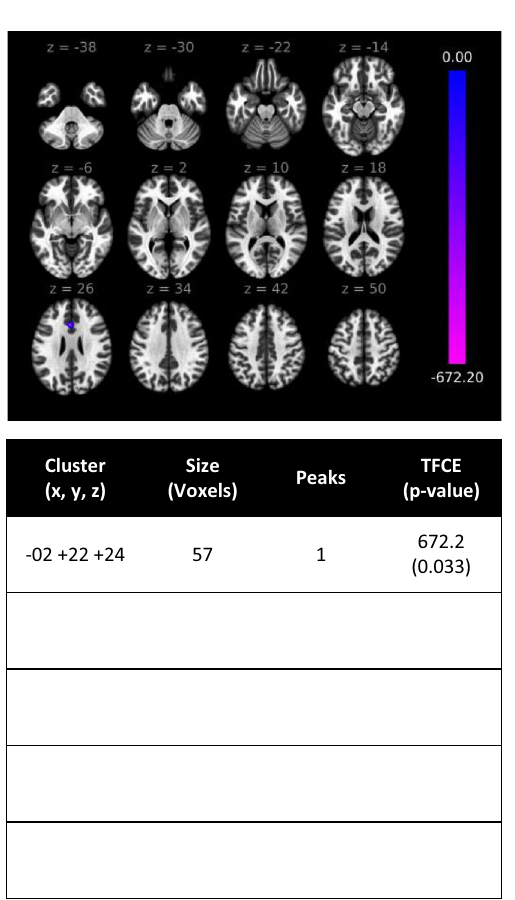
Figure 3. rs-fMRI differences between males with concussion and healthy males. Clusters (x, y, z) denote standard MNI coordinates at the center of cluster mass, and size represents number of voxels. Only one cluster survived